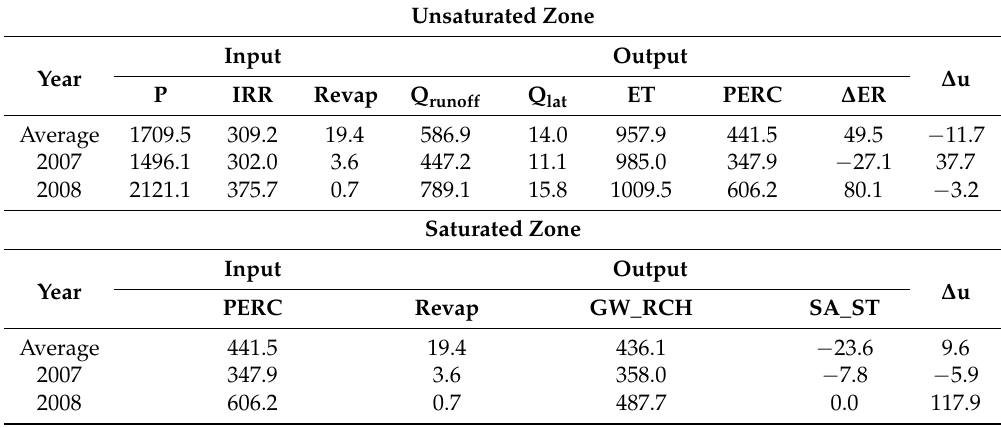
Table 1. Monthly water balance for an average precipitation year, expressed in mm/y for unsaturated and saturated zone.